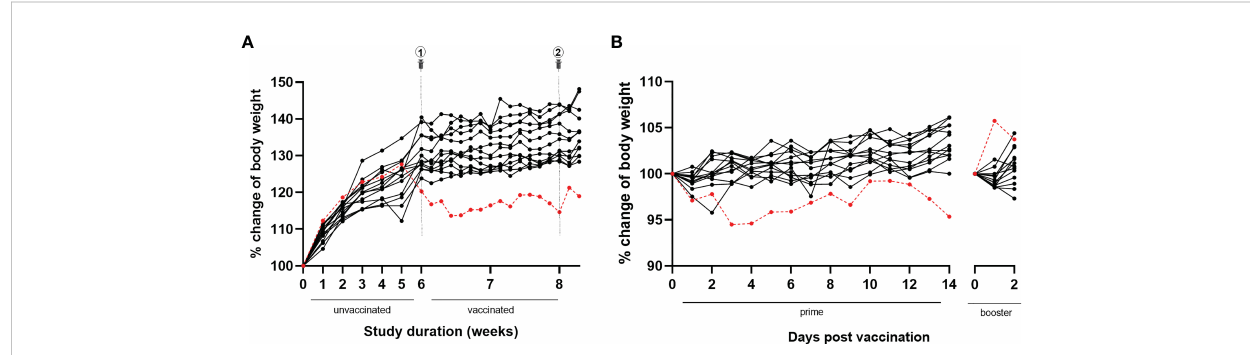
FIGURE 4 Body weight evolution throughout the study and following BNT162b2 prime and booster. (A) During the full study course, the animal of this case report ( red dotted line ) was weighed weekly until primary vaccination and daily afterwards. Over the fi rst fi ve study weeks, the animal ’ s body weight gradually increased reaching peak body weight. Afterwards, a drop in body weight was observed, without recovery. In contrast, all other animals belonging to the same experimental group ( black lines ) showed a progressive increase of body weight over time. (B) Similar to the other animals belonging to the same experimental group ( black lines ), the animal of this case report ( red dotted line ) showed a slight decrease in body weight following primary immunization. In contrast with the other animals, a remarkable 5.7% increase in body weight was observed following booster